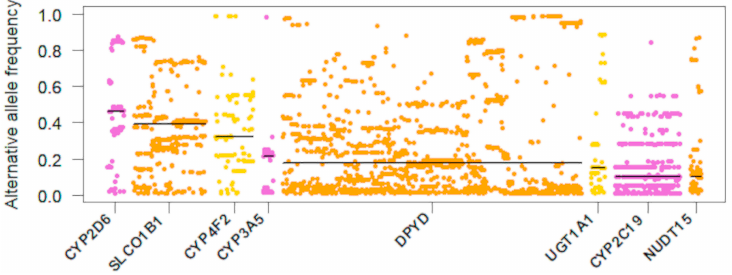
Figure 1. Single-nucleotide variants of pharmacogenes with alternative allele frequencies of more than 10% in a Korean population. Horizontal lines indicate median values.